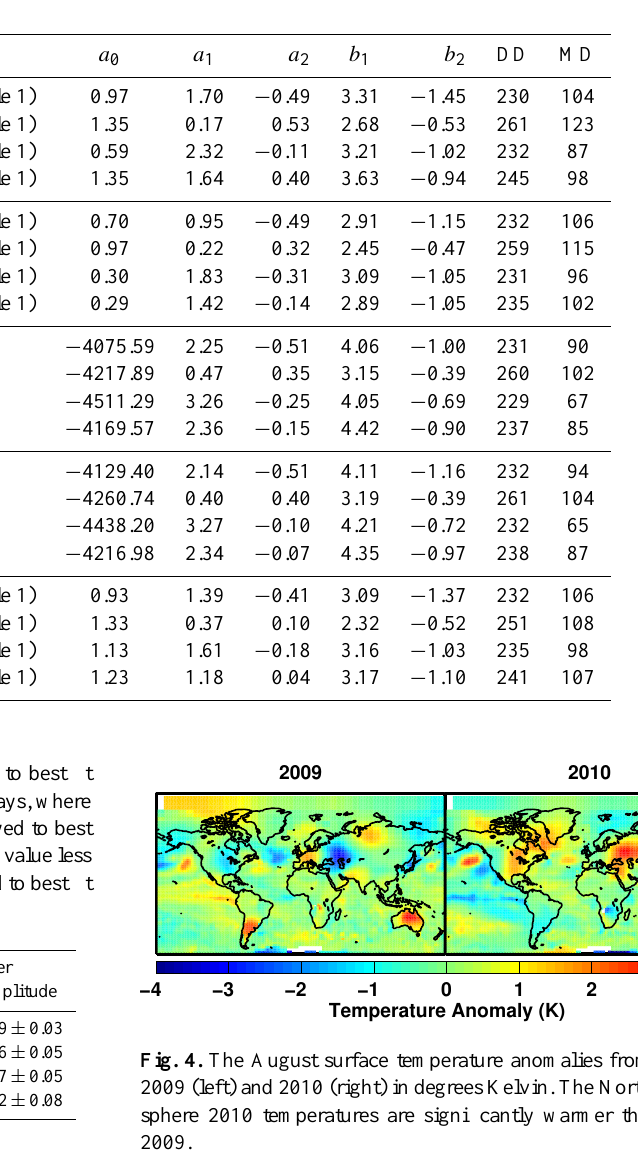
Table 2. Curve fitting parameters for Eq. (2). The parameters α and a 0 represent the linear secular increase: α is in ppmyr − 1 , and a 0 is the y intercept in ppm. Parameter a 1 (ppm) represents the amplitude of the cos ( 2 πx) term, and b 1 (ppm) represents the amplitude of the sin ( 2 πx) term. The a 2 and b 2 parameters are the amplitudes of the cos ( 4 πx) and sin ( 4 πx) terms, respectively. The drawdown date (DD) and seasonal cycle maximum date (MD) are the dates of the local minima and maxima of the fitted curves, respectively, in day of the year. The large negative values of a 0 for SiB and SiB2009 are the result of using a straight-line fit to the data (i.e., α ) instead of subtracting the ESRL growth curve, and fitting the detrended curve.